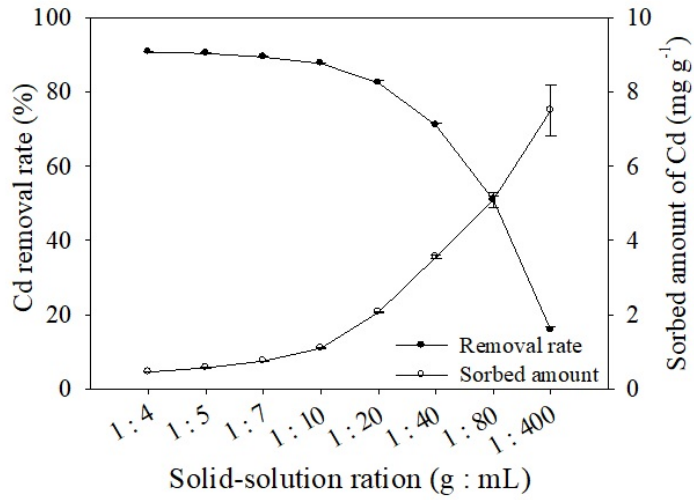
Figure 4. Cd removal rate ( ● ) and the amount of Cd adsorbed per a unit (g) of spent coffee grounds ( ○ ) with an increase in the solid:solution ration.